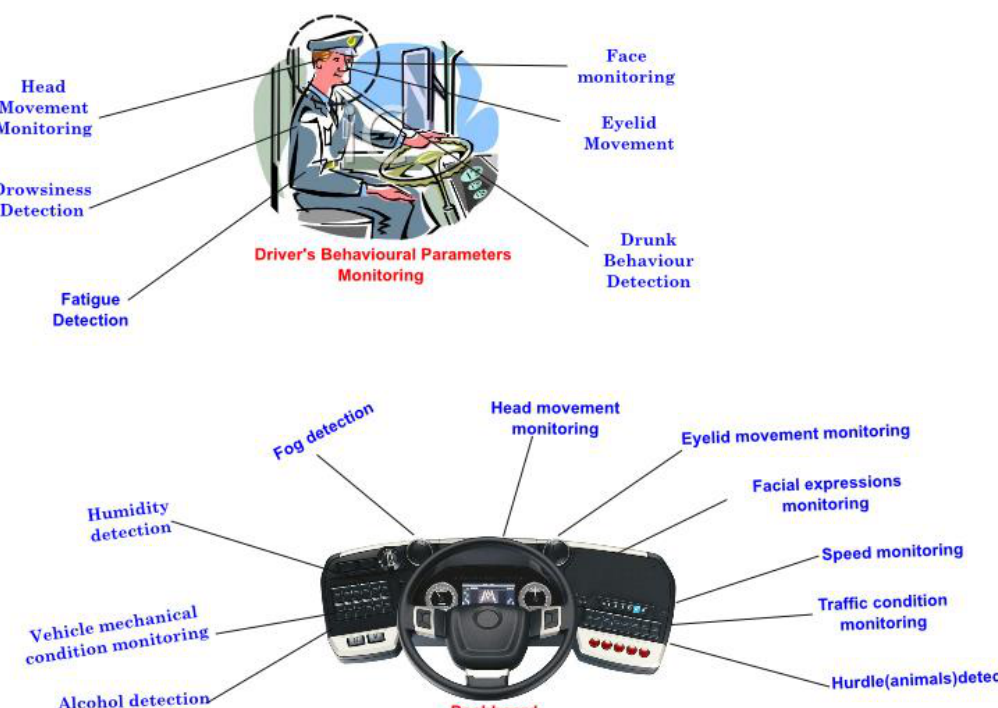
Fig. 4 Pictorial representation of the driver behavior and dashboard of the